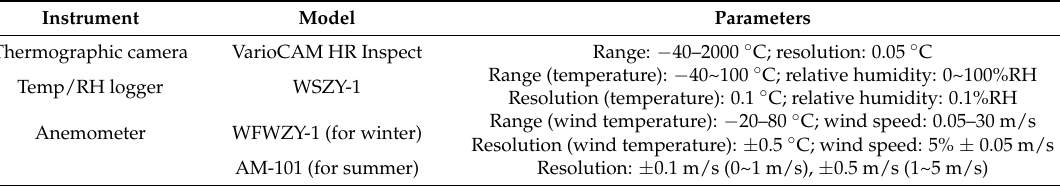
Figure 5. Measuring points in the selected vernacular house. Table 2. Parameters of the Test